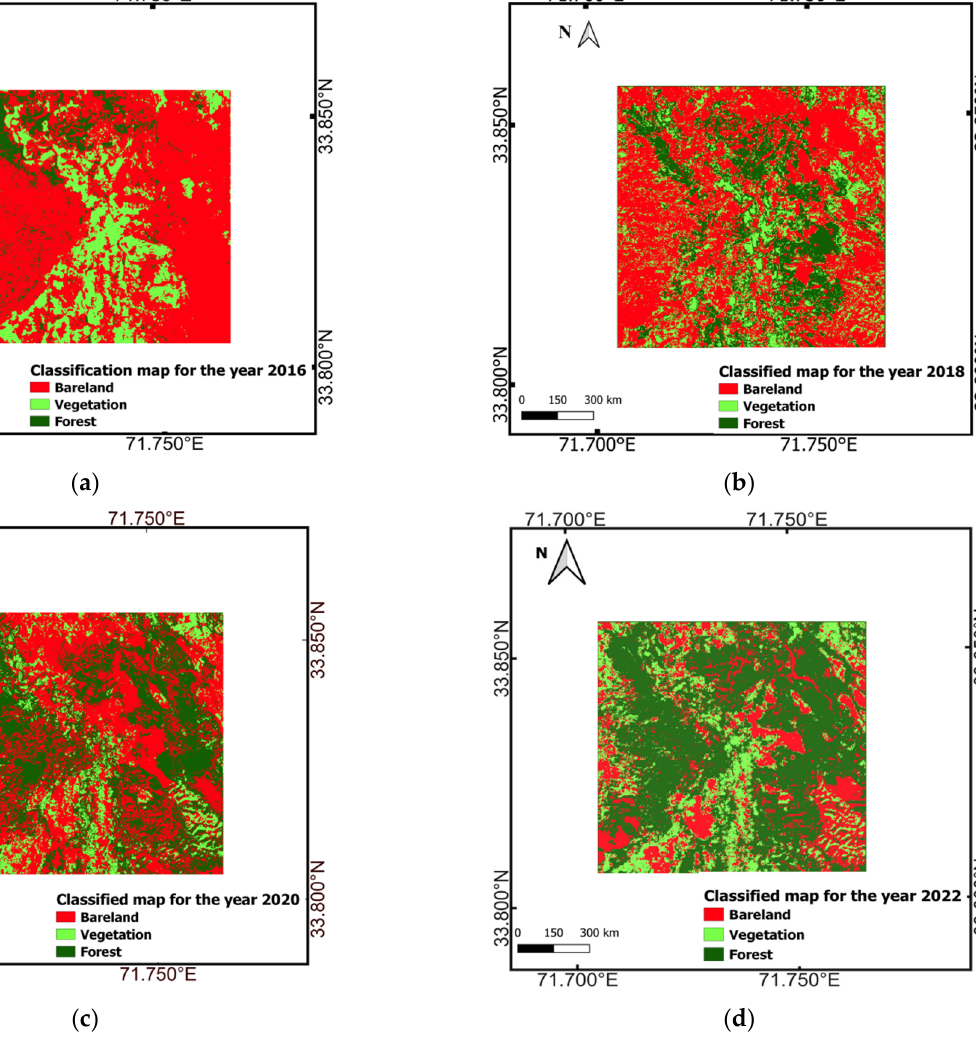
Figure 9. Classified images for the years ( a ) 2016, ( b ) 2018, ( c ) 2020, ( d ) 2022.